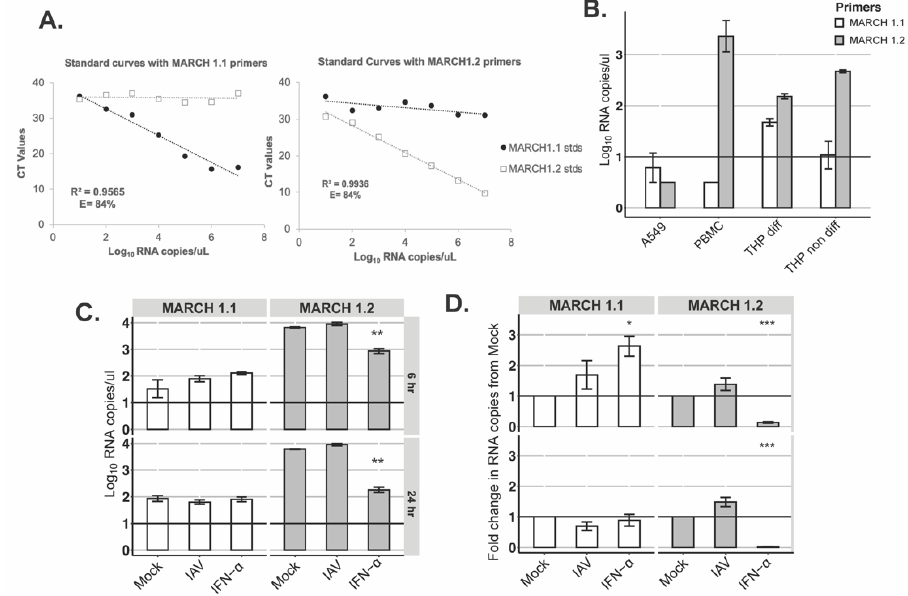
Figure 5. Endogenous expression MARCH1 isoforms in different human cell lines and primary cells following induction was measured by qPCR . ( A ) Primers specific to MARCH1.1 (left panel) or MARCH1.2 (right panel) isoforms were designed and qPCR efficiency and specificity was tested using plasmid standards encoding MARCH1.1 or MARCH1.2. Data confirm primer specificity and PCR efficiency was calculated as 84% and 87% for MARCH 1.1 and MARCH1.2 primers, respectively. Data are representative of >two independent experiments ( B ) Endogenous expression levels of MARCH1 isoforms in different cell lines were measured using the optimised qPCR primers and plasmid standards to determine absolute RNA copy numbers. For qPCR, the total RNA was extracted from cells, and 50 ng/ µ L of each sample was DNase-treated and then used for cDNA synthesis. Data show the mean ± SD from triplicate samples for cell lines (A549, THP-1), from four independent donors (PBMC). ( C , D ) The induction of MARCH1 isoforms following IAV infection or IFN-a treatment as determined by qPCR. Monocyte-derived macrophages (MDMs) were cultured in 24-well plates and infected with IAV (Beijing/89, MOI 10) or treated with 1000 U/mL IFN-a for 6 or 24 h. After